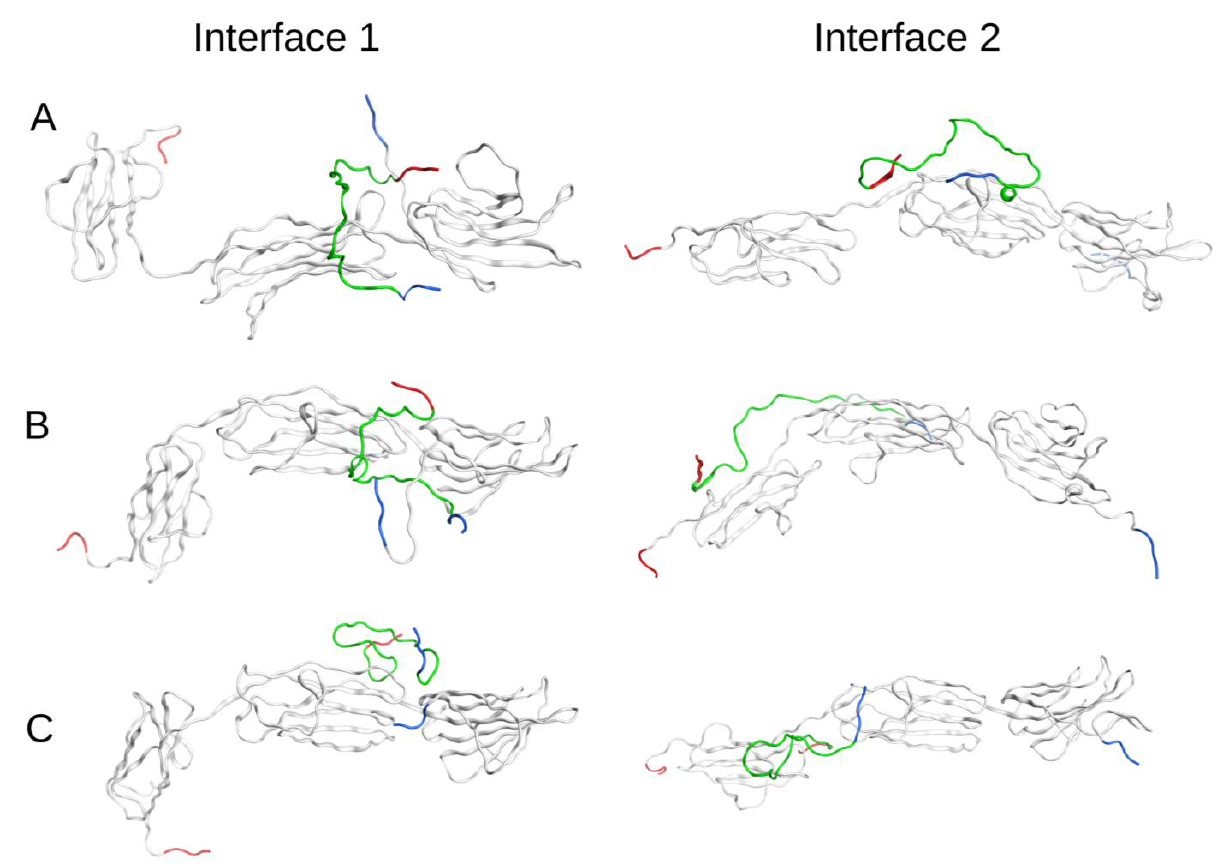
Figure 3. The best docking RAGE:Aβ complexes for the three Aβ 42 isoforms after 100 ns of MD. ( A ) RAGE with Aβ 42 , ( B ) RAGE with isoD7- Aβ 42 , ( C ) RAGE with pS8- Aβ 42 . The Aβ 42 peptides are colored green, N-termini are highlighted with blue and C-termini are highlighted with red.